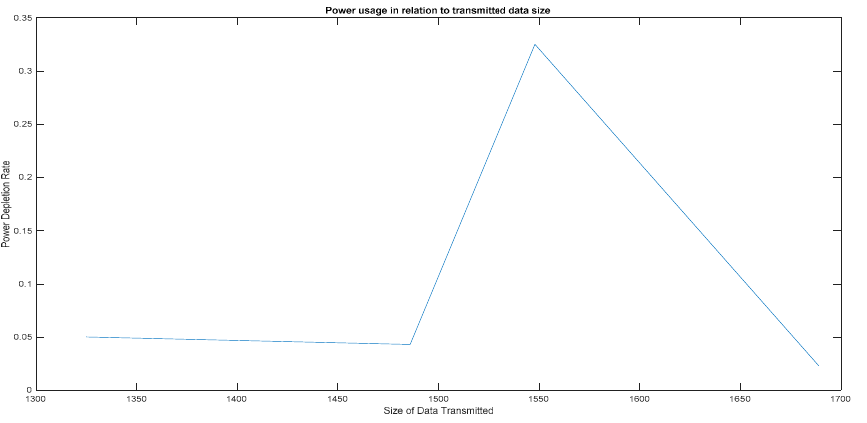
Figure 5. Power usage in relation to transmitted data size.